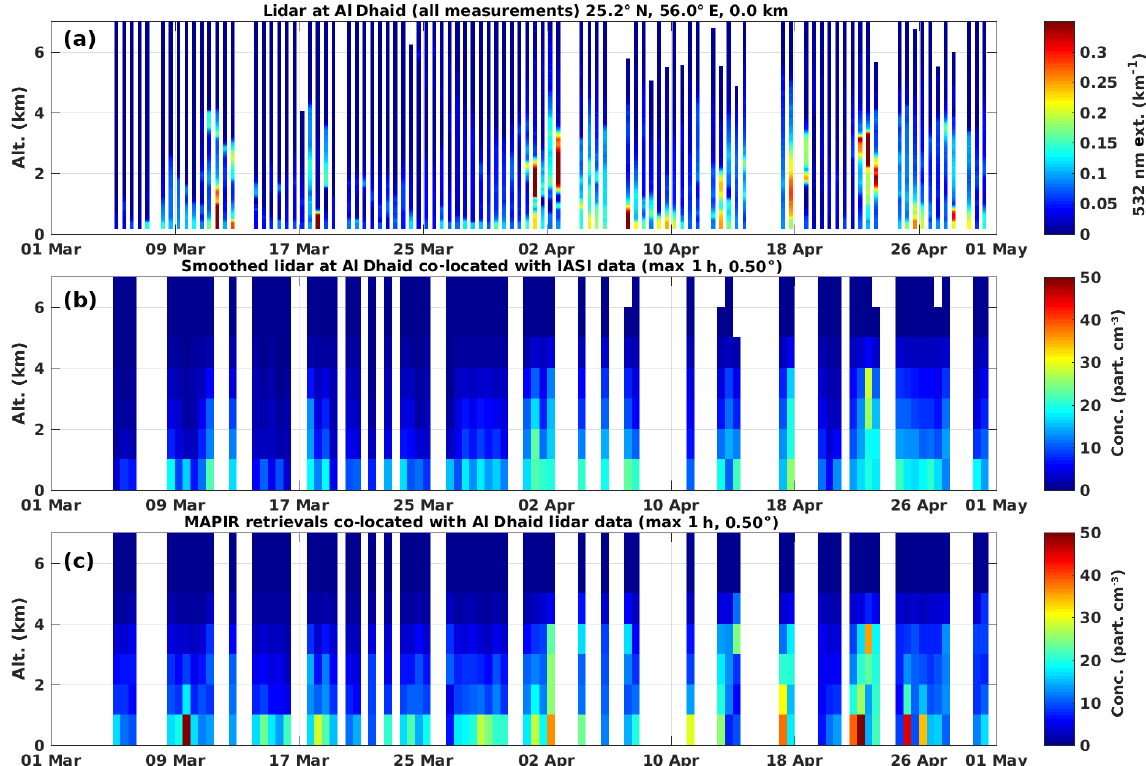
Figure 10. Mineral dust profile comparison at the Al Dhaid site (UAE) from 1 March to 1 April 2018. Panel (a) gives the lidar data (extinction profiles at 532nm) as provided for this study. In panel (b) , the lidar data smoothed according to Eq. (7) are presented, for those times when there is a co-located MAPIR profile. Panel (c) presents the MAPIR profiles over time averaged around the Al Dhaid